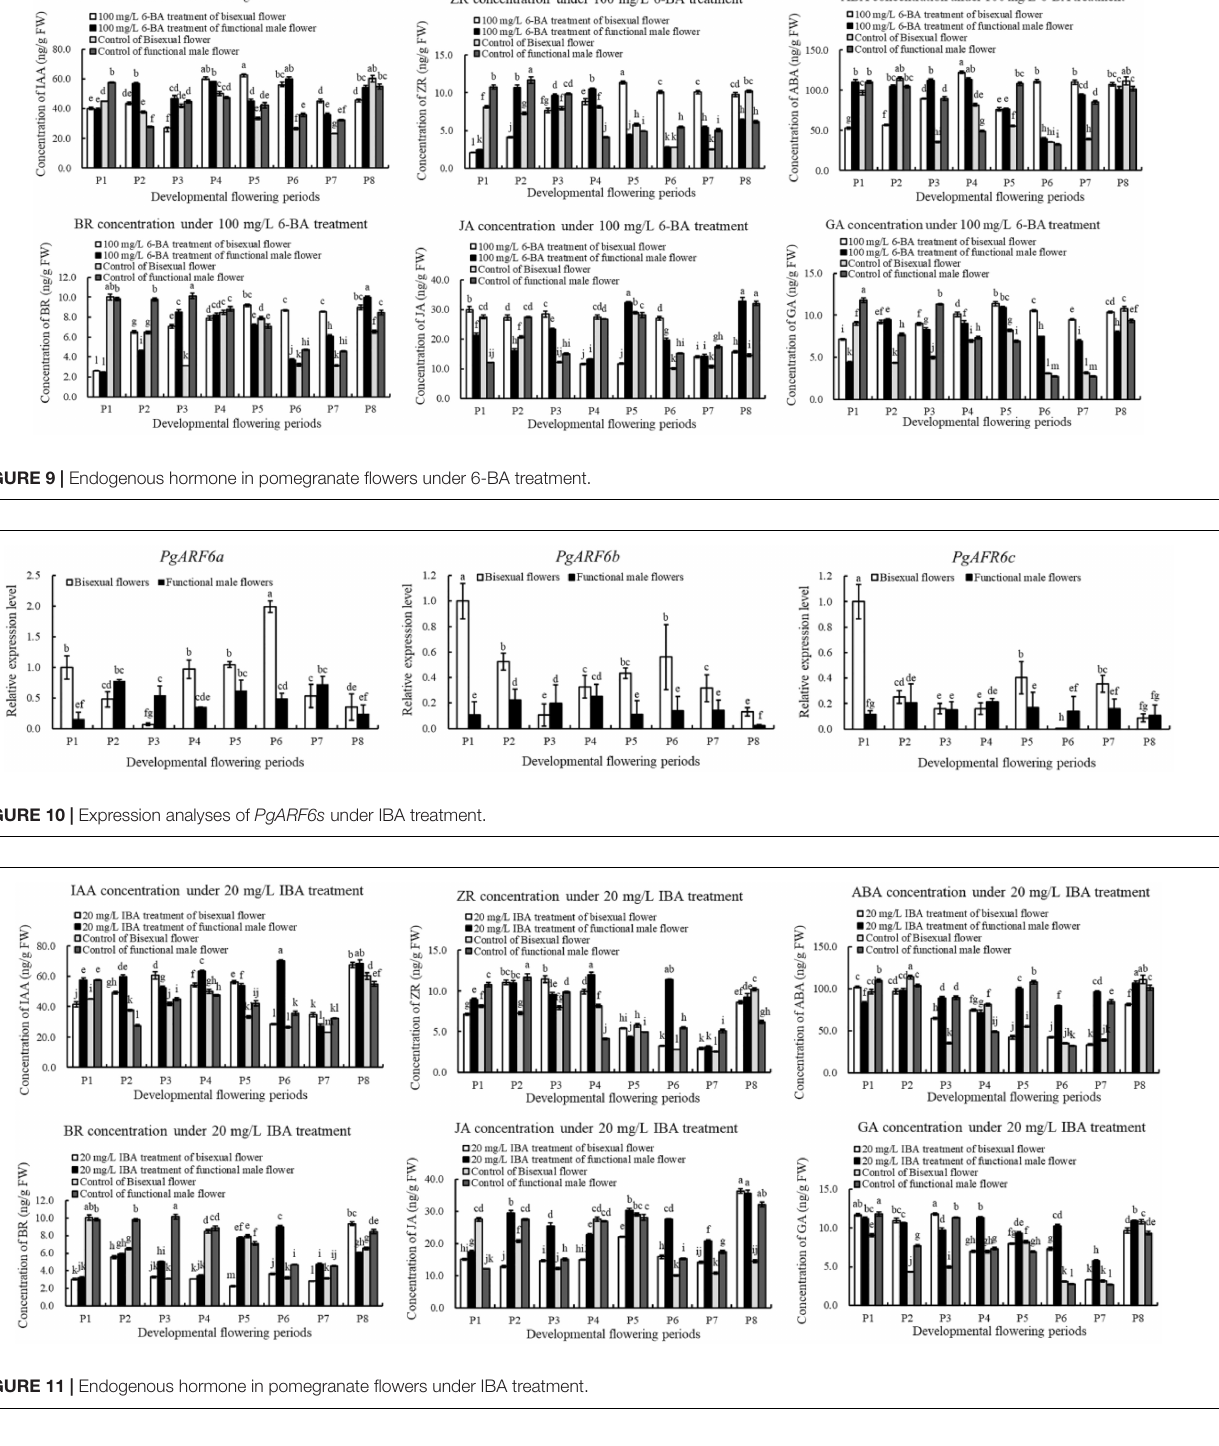
ovule development, the concentration of BR in the treatment was lower than that in the control. During the functional male flowers development, BR content in the treatment was lower than that in the control at P1–P4 stages, but higher than that in the control at P5–P7 stages.